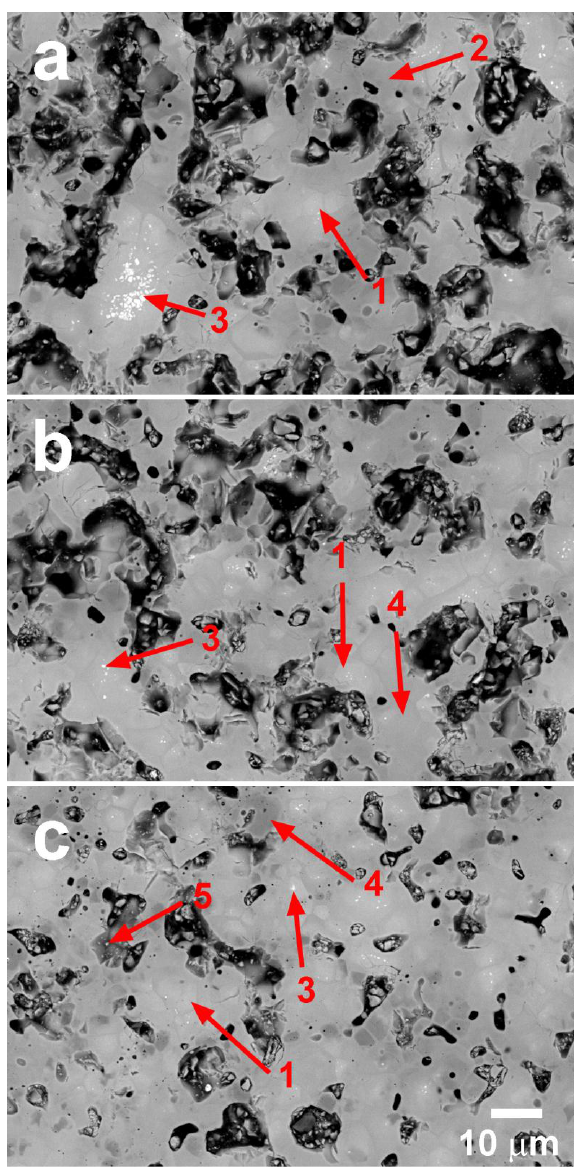
Figure 3. FESEM micrographs performed on representative polished surfaces of Ca 0.9 Yb 0.1 MnO 3 + x wt.% Ag samples for x = ( a ) 0; ( b ) 1; and ( c ) 5. The different phases are indicated by numbers: #1 is Ca 0.9 Yb 0.1 MnO 3 ; #2 is Yb-poor Ca 1-x Yb x MnO 3 ; #3 is Yb-rich Ca 1-x Yb x MnO 3 ; #4 is the Ca 2 Mn 2 O 5